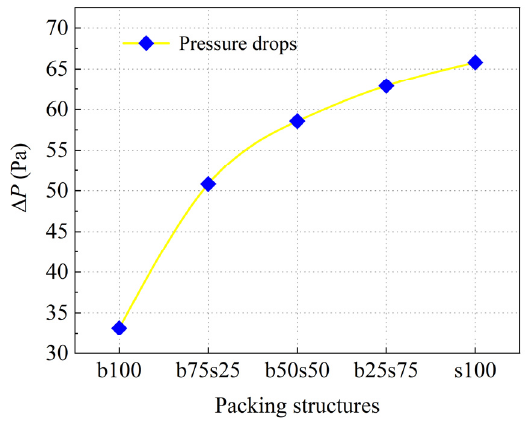
Figure 12. Pressure drops along the axial direction of different packed